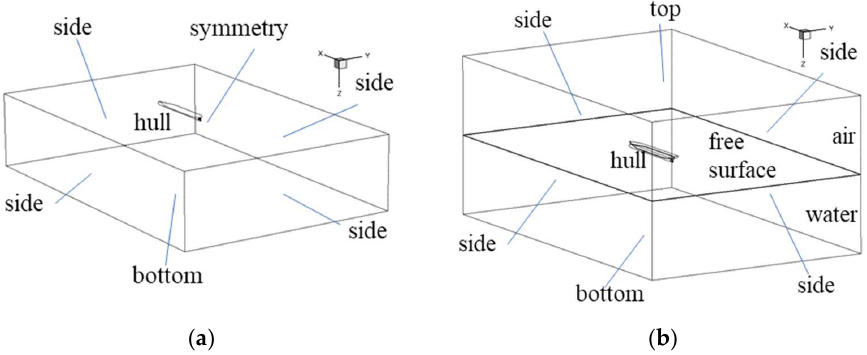
Figure 1. Computational domain and boundaries. ( a ) Double-body flow. ( b ) Water–air flow. For both simulations of double-body flow and water–air flow, on the four side boundaries, i.e., the boundaries at x = 2 L pp , x = − 2.5 L pp , and y = ± 1.5 L pp , if the fluid enters